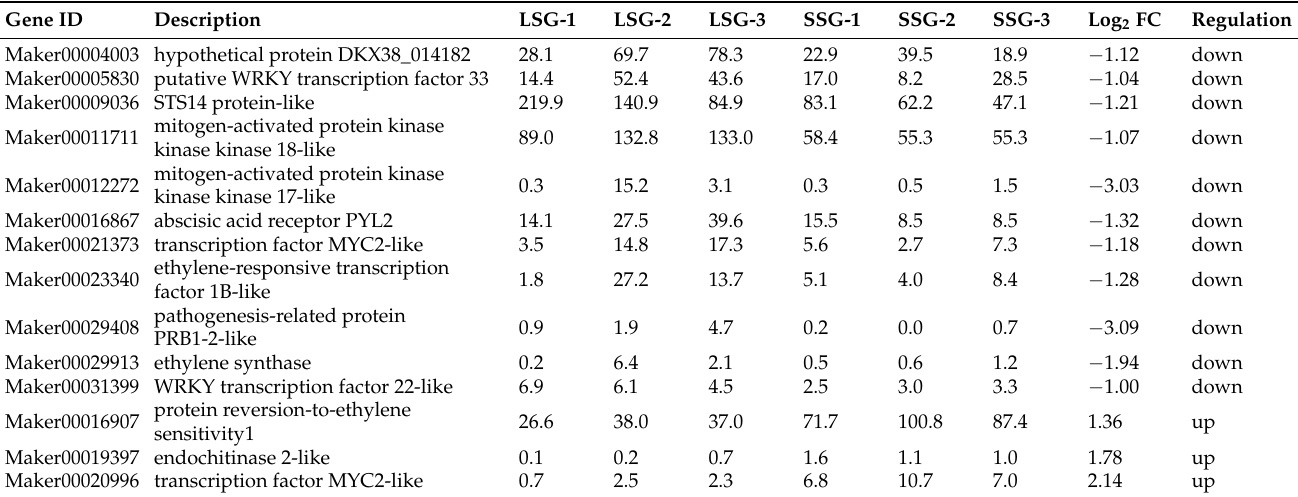
Table 5. DEGs involved in MAPK signaling